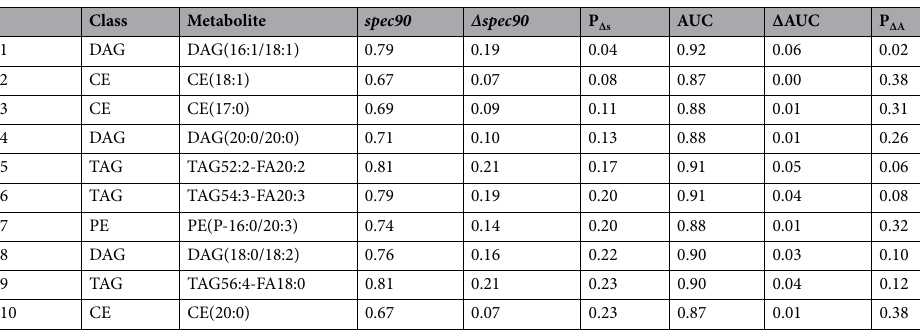
Table 2. Performance characteristics of single lipid species combined with CA125, age, and BMI, in classifying early-stage (I-II) cases versus controls. Using data from the RP cohort, logistic regression was used to model the log odds of case status as a linear function of log 2 CA125, age, and BMI, with or without a given lipid metabolite (M), after imputing missing values for each species to ½ the minimum concentration detected for that species across all participants. Receiver operating characteristic (ROC) curve analysis was conducted to estimate area under the curve (AUC) and specificity at 90% sensitivity ( spec90 ) conferred by the joint model (with M) versus the base model (without M: AUC = 0.865, spec90 = 0.603). Lipids with Δ spec90 > 0.05 were selected and ranked by corresponding P value (P Δs ). Performance metrics listed for top 10 lipid species.